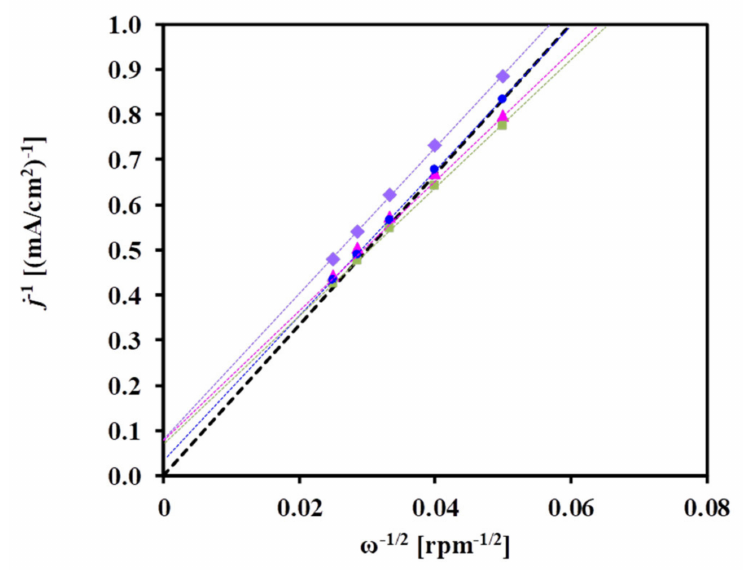
Figure 9. Koutecky–Levich representation of HOR measurements obtained at 250 mV on the ( (cid:4) ) Pt/75BP, ( (cid:78) ) Pt/75F-BP, ( • ) Pt/75V, and ( (cid:7) ) Pt/C